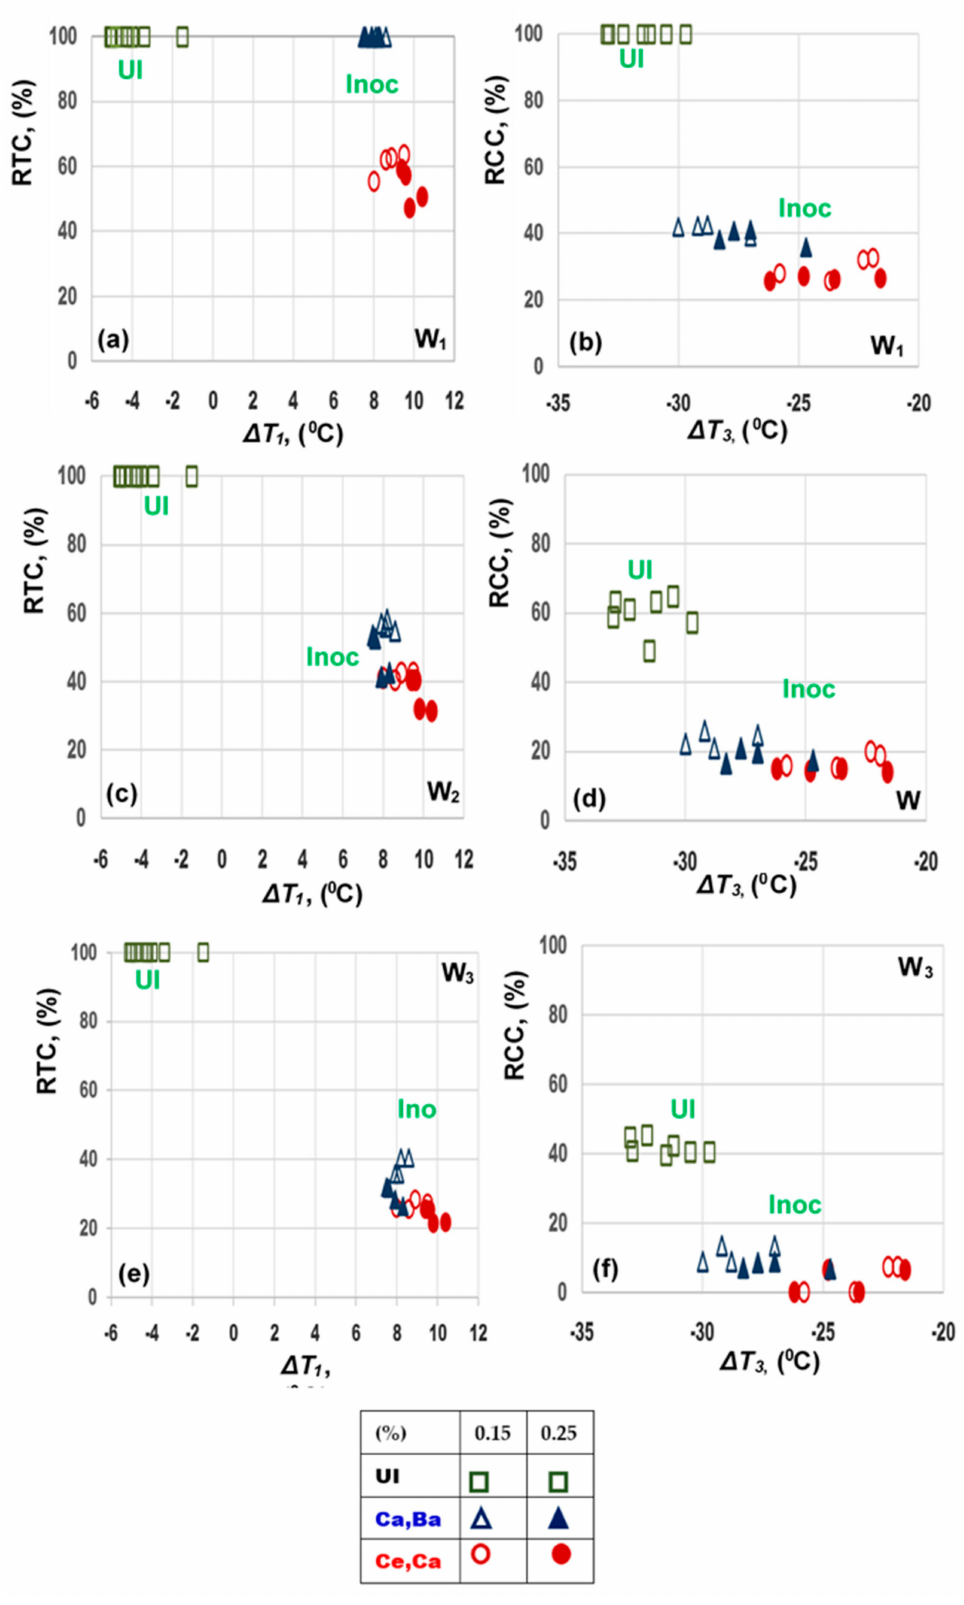
Figure 10. Relative Total Chill (RTC) in relation to undercooling at the beginning of eutectic reaction ( ∆ T 1 ) ( a , c , e ) and Relative Clear Chill (RCC) in relation to undercooling at the end of solidification ( ∆ T 3 ) ( b , d , f ) of wedge samples (W 1 , W 2 , W 3 ) (UI/Inoc—un-inoculated and inoculated (Ca,Ba/Ce,Ca) grey cast